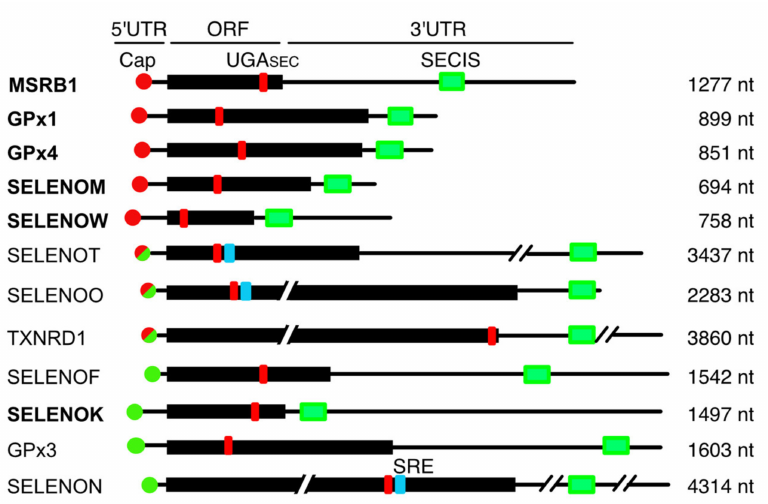
Figure 6. Characteristics of selenoprotein mRNAs bound by eIF3. The schematic representation of the selenoprotein mRNAs summarizes the analysis presented in Table S3. The names of the mRNAs bound by eIF3 are in bold. The open reading frames are represented by black rectangles, 5 (cid:48) UTR and 3 (cid:48) UTR by black lines. The position of the UGA Sec is indicated in red. The SECIS element is in green. The Sec redefinition element (SRE) is in blue. The cap is represented by a dot. Selenoprotein mRNAs are classified according to the nature of their 5 (cid:48) cap structures, as previously described [23]. Red dots: selenoprotein mRNAs with hypermethylated m 32,2,7 G caps that are not recognized by eIF4E, Red/green dots: selenoprotein mRNAs with m 32,2,7 G capped mRNAs that are weakly recognized by eIF4E. Green dots: m 7 G capped selenoprotein mRNAs that interact with